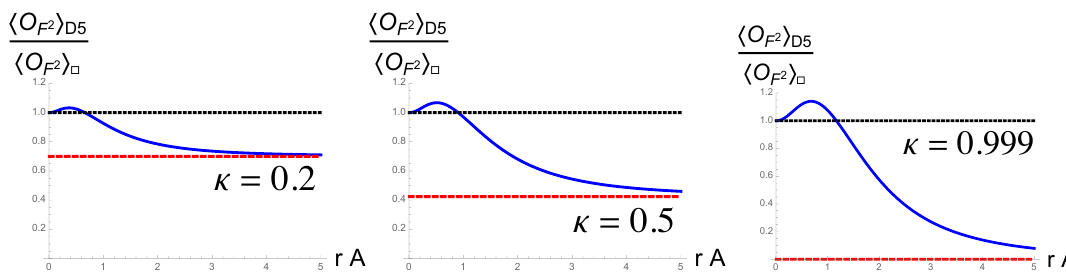
Figure 4 . The VEV of the dimension four operator O dual to the dilaton, in the presence of F 2 the non-conformal impurity, divided by the corresponding VEV due to k coincident quarks (dotted black), plotted (solid blue) as a function of ( rA ). The red dashed line denotes the VEV of the same operator in the presence of the source in representation A k